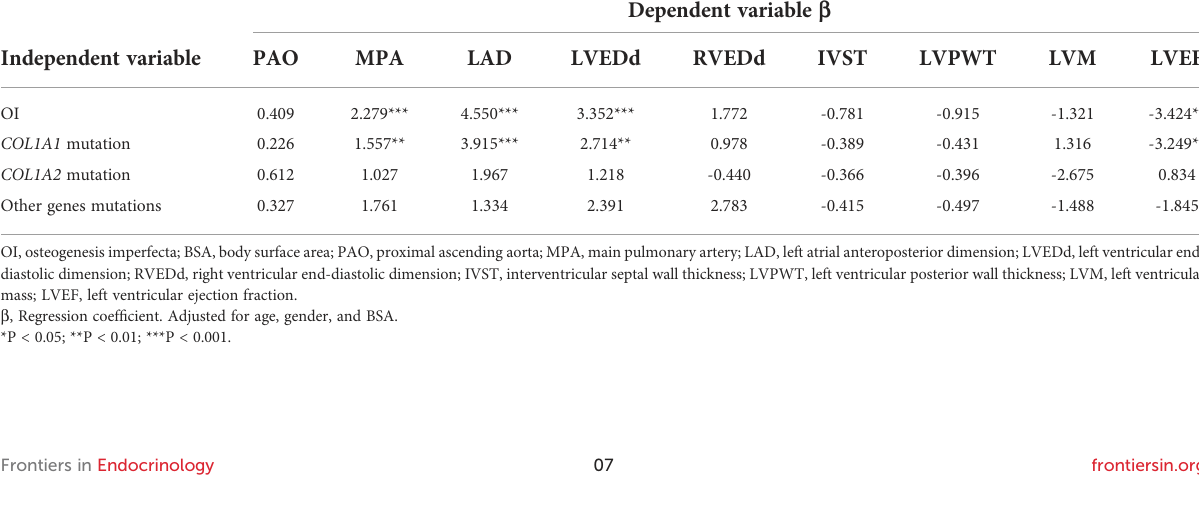
TABLE 6 Correlation between OI genotypes and echocardiographic parameters.